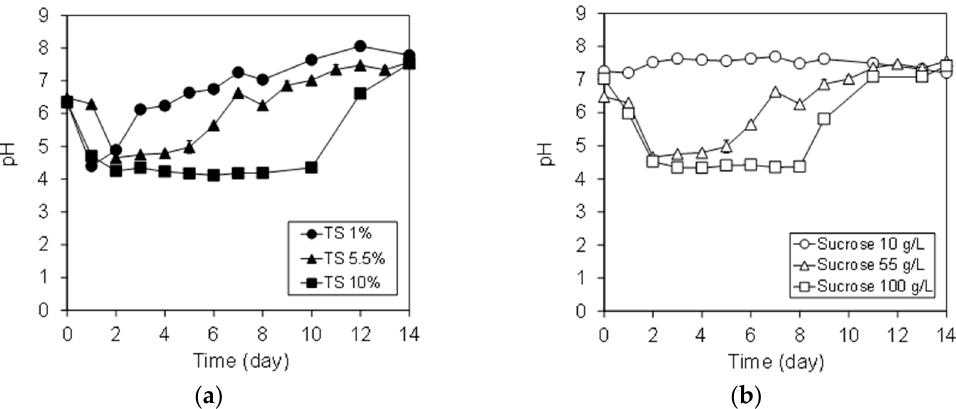
Figure 1. Variations of pH during the fungal bioleaching experiments ( a ) effects of sludge solid content, ( b ) effects of sucrose